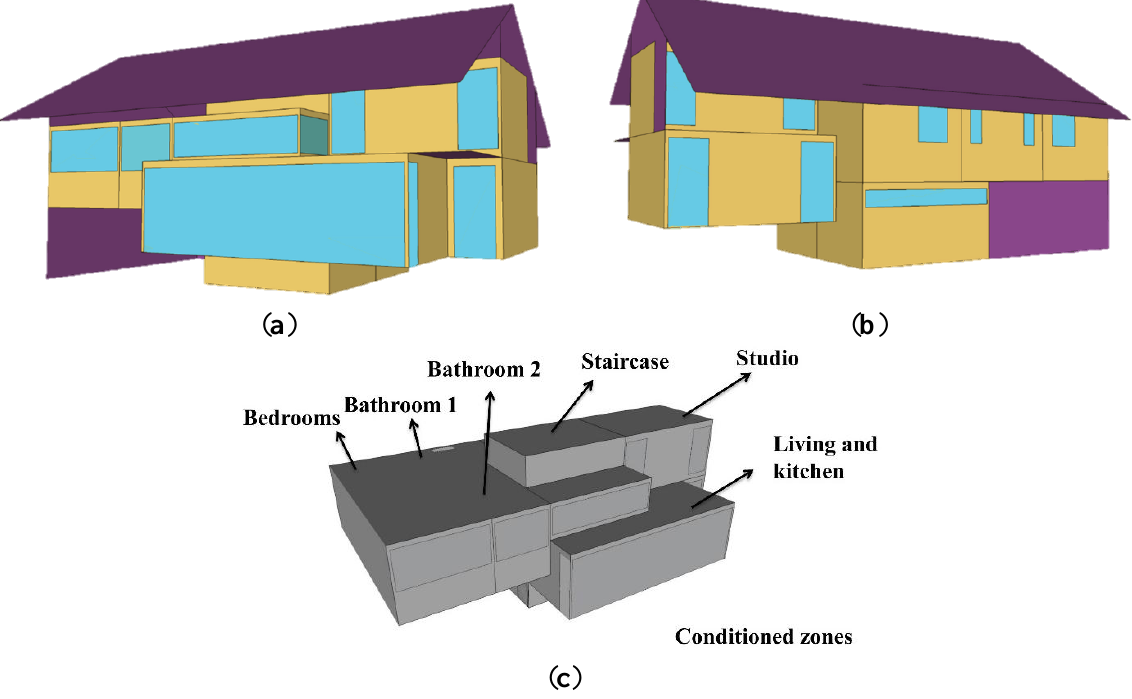
Figure 6. ( a ) Axonometric view: south façade; ( b ) Axonometric view: north façade; ( c ) Subdivision into thermal